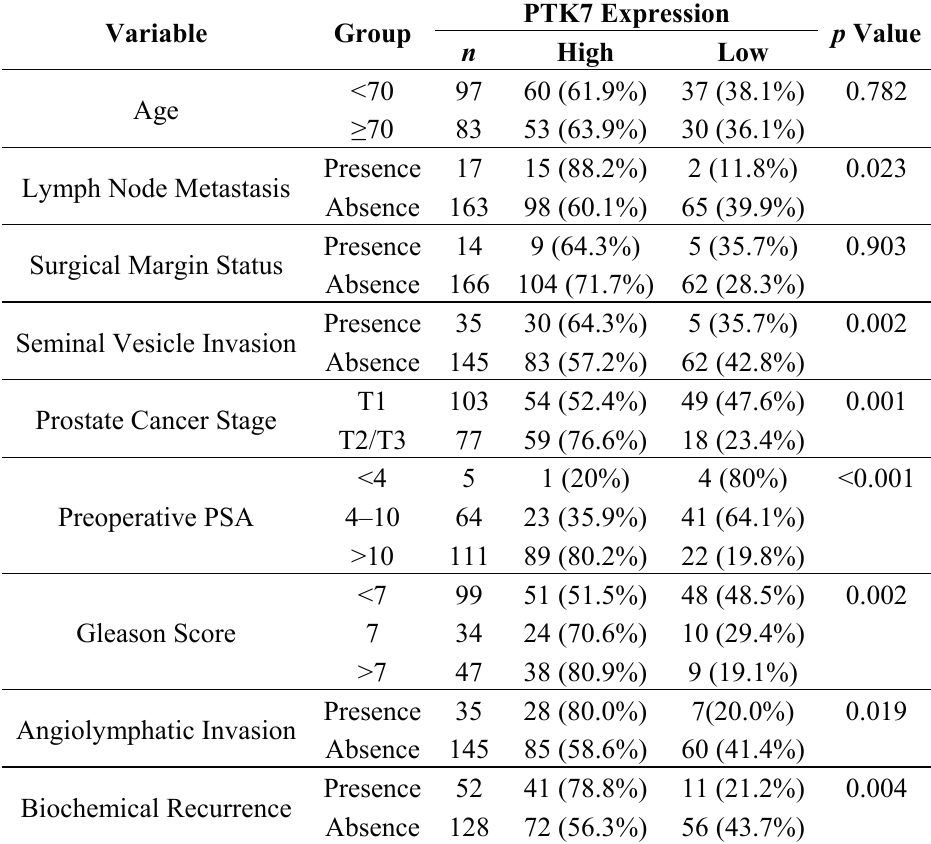
Table 1. Clinicopathologic variables and PTK7 expression in 180 prostate cancer